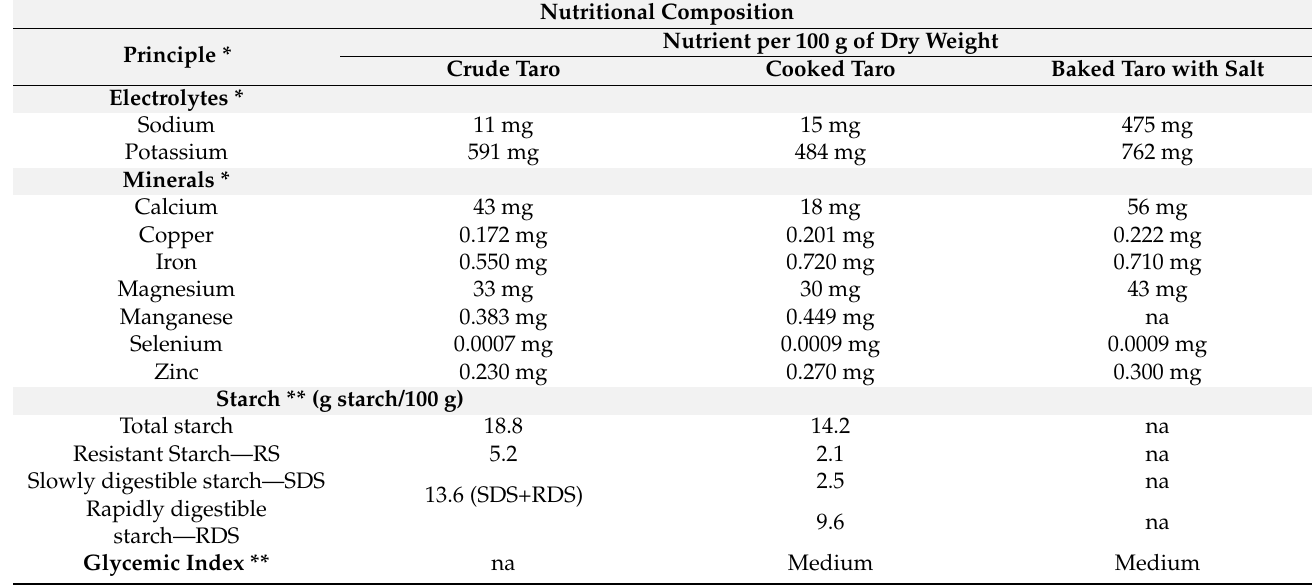
Table 1. Cont. Nutritional